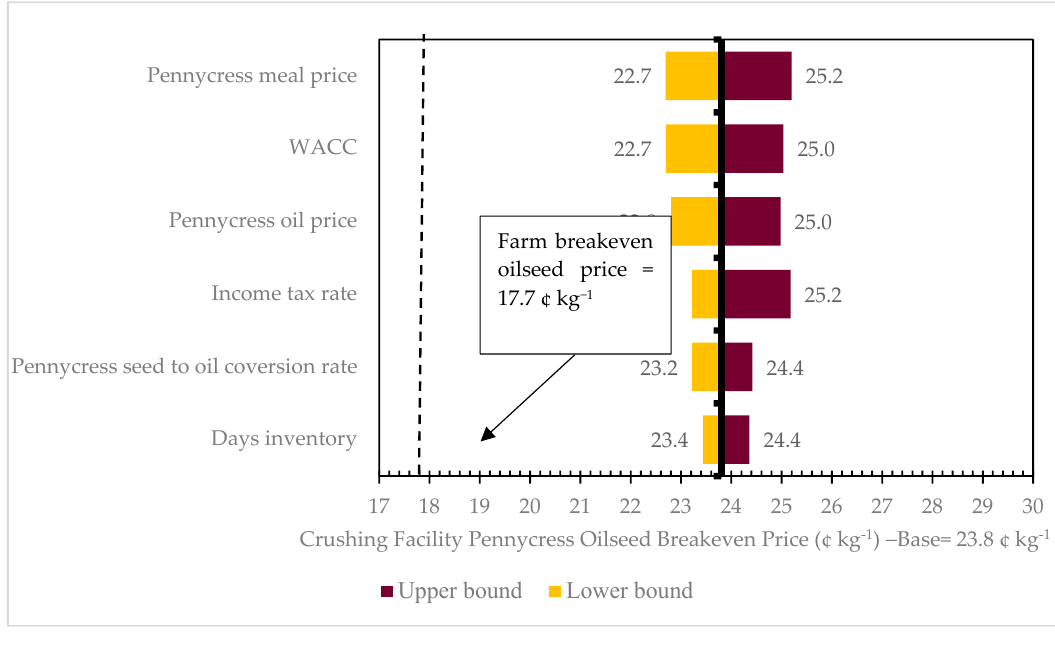
Figure 3. Breakeven and one-way sensitivity analysis of maximum pennycress purchase prices for the crushing facility to obtain NPV = 0. Notes: Input assumptions for the base, lower bound, and upper bound scenarios are presented in Table 2 .